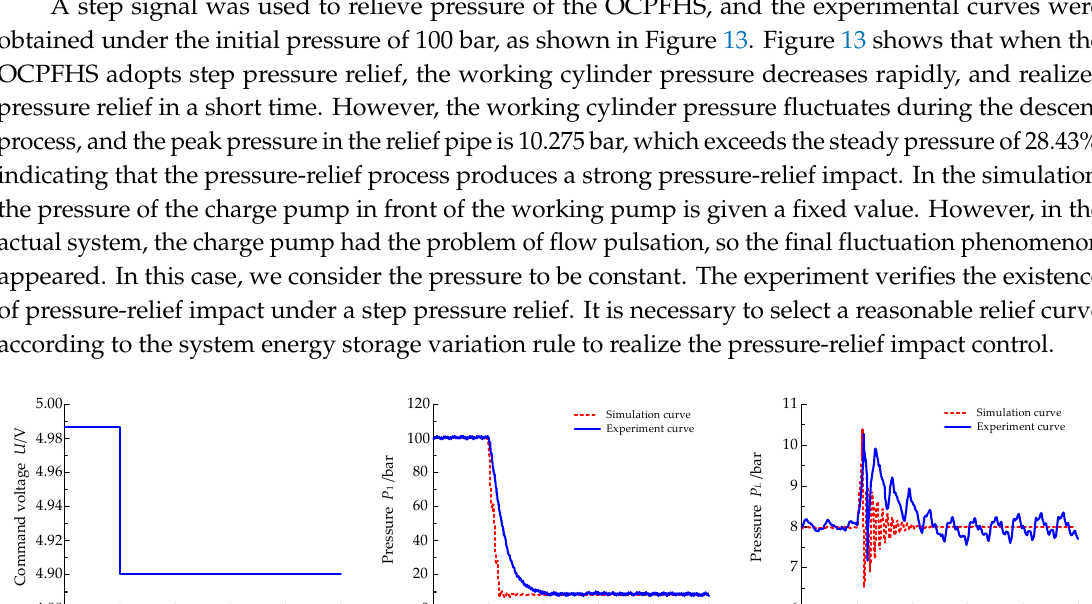
Figure 14. The system response curve under initial pressure of 100 bar. ( a ) Working cylinder pressure; ( b ) Relief-pipe pressure.